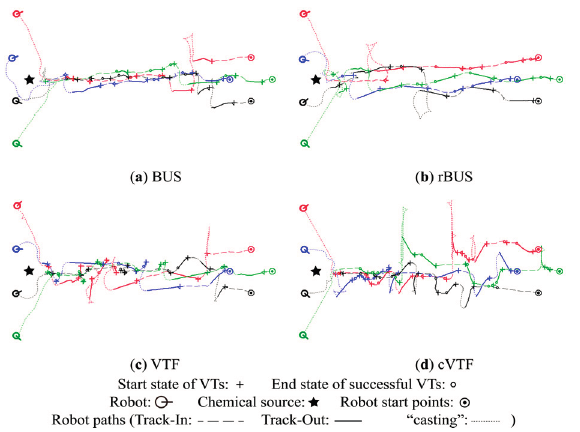
Figure 13. Typical robot trajectories obtained in M